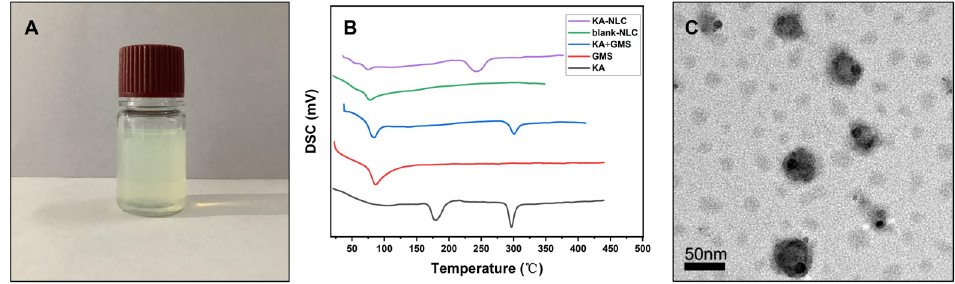
Figure 3. ( A ) Appearance of KA-NLC. ( B ) Thermograms of KA-NLC, blank-NLC, physical mixture of KA and GMS, GMS, and KA. ( C ) TEM images of optimal KA-NLC; the optimal formulation is as follows: the ratio of lipid and drug = 34.72:1, the ratio of solid lipid and liquid lipid = 4:1, and sur- factant concentration = 1% ( w / v